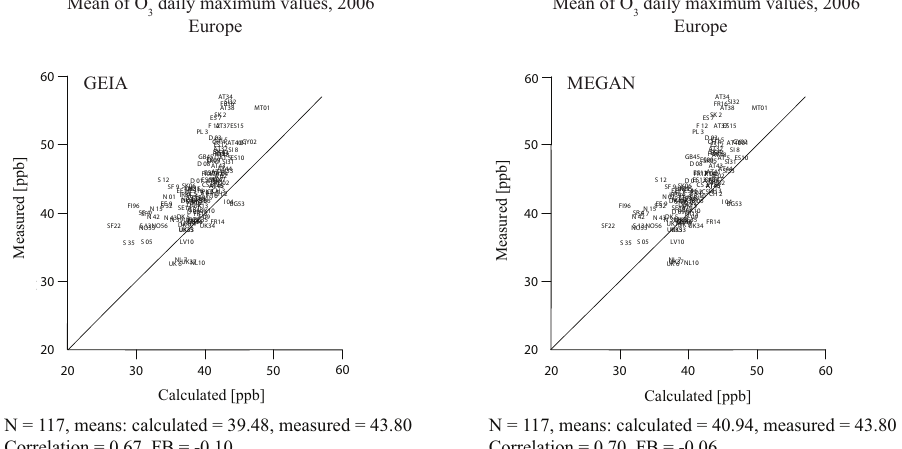
Fig. 12. Comparison of measured and predicted mean values of the daily maximum ozone concentrations with DEHM-GEIA and DEHM- MEGAN at 117 rural background stations of EMEP for the year 2006.